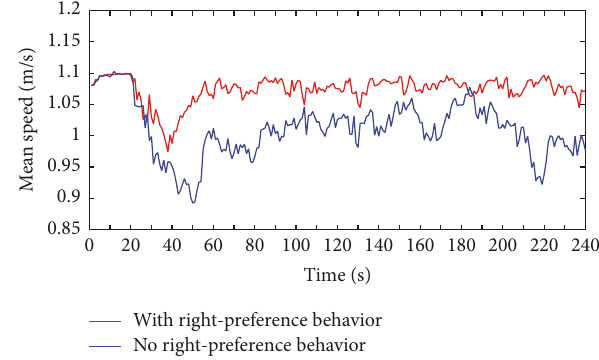
Figure 18: The plot of the mean speed versus the time. In the simulation, the desire speed of pedestrian V 0 𝑖 = 1.1 m/s, the pedestrian arrival rate is 0.2 P/(m ⋅ s), 𝜙 = 1 , and 𝜆 = 0.2